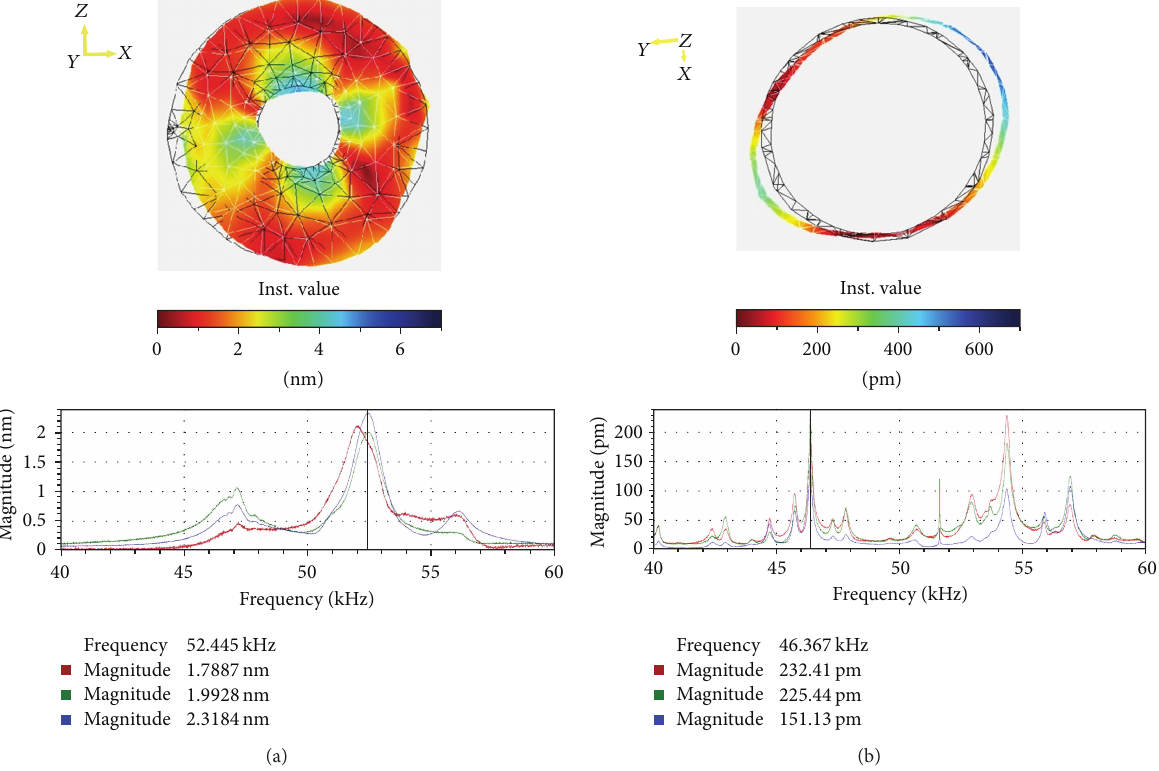
Figure 12: Distribution of displacement amplitudes on the top surface of actuators: symmetric ring type actuator at 52.445 kHz (a), cone type actuator (46.367 kHz)